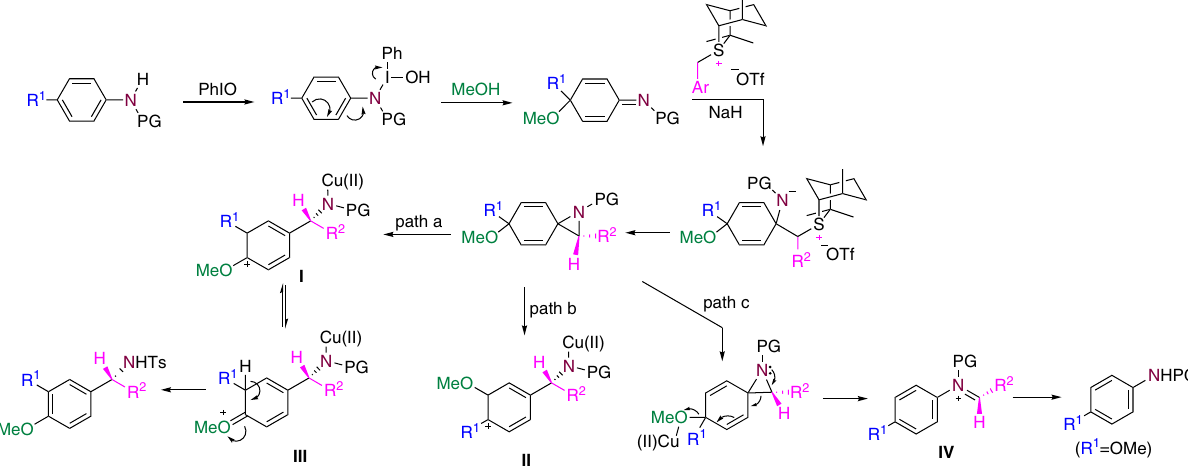
Fig. 7 Plausible reaction pathway. Path a is the preferred way for the formation of the one-carbon insertion product accompanied by a migration of the para -substituent to the meta position and concomitant para -substitution by a nucleophilic